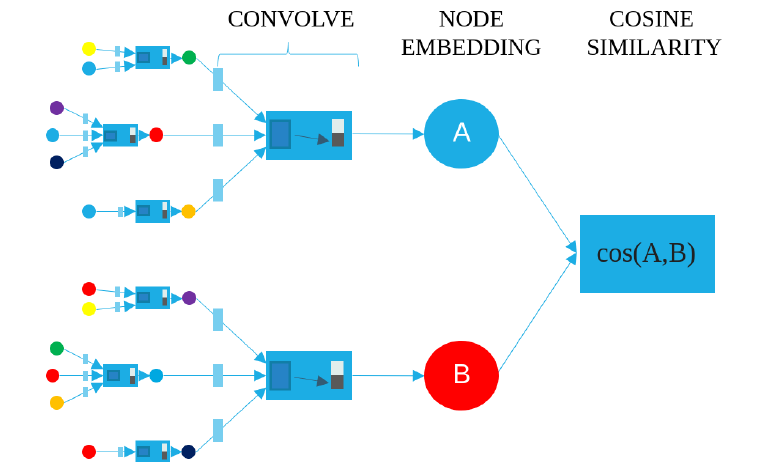
Figure 1. The graph convolutional neural network uses localized convolutions on aggregated neighborhood vectors to learn product embeddings. Here, we show the two layer graph neural network that computes the final embeddings of nodes A and B using the previous layer representation of nodes A and B, respectively, and that of their respective neighborhoods. Different colors denote different nodes. The recommendation score between two products A, B is then computed via the utilization of the cosine similarity between the two final embedding vectors of nodes A and